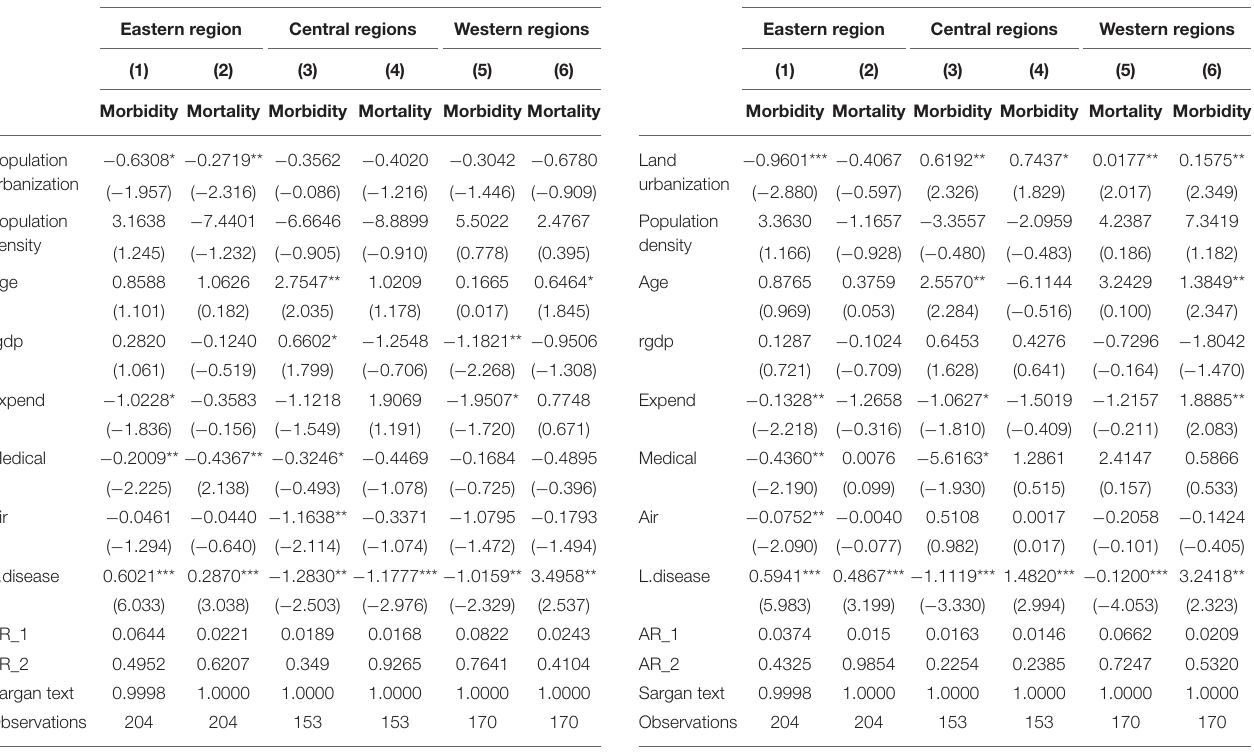
TABLE 3 | Regional differences in the impact of population urbanization. Variables